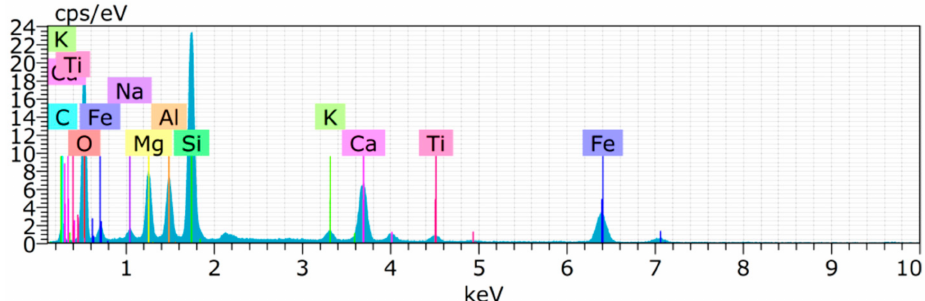
Figure 15. XRD pattern of copper slag.